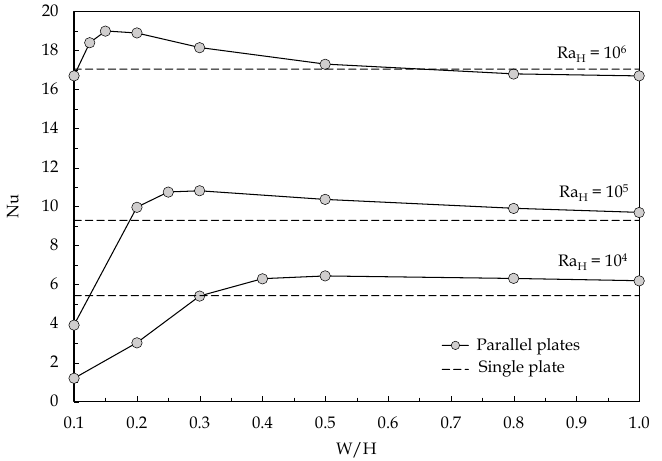
Figure 6. Nu vs. W / H for L / H = 1 (face-to-face plates) using Ra H as the